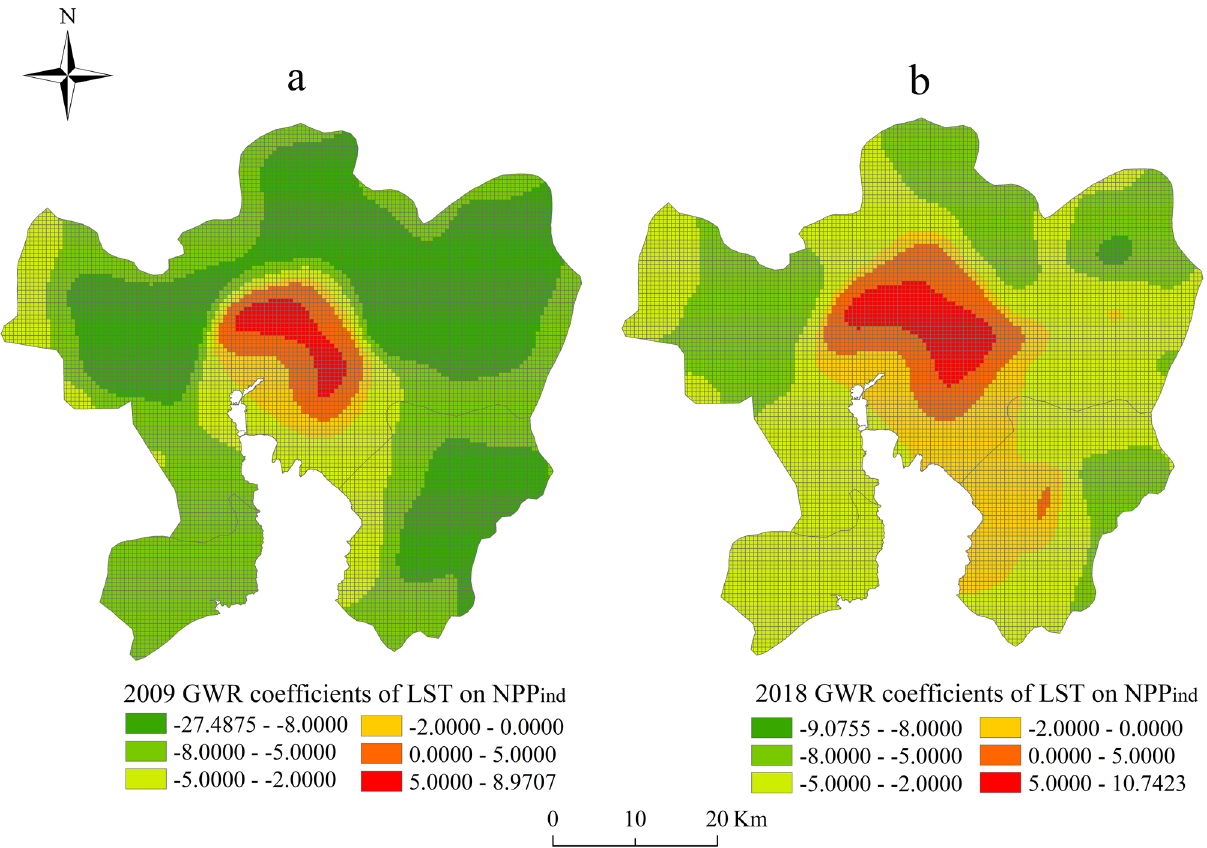
Figure 4. The spatial distribution of the GWR local coefficients of LST on NPP ind